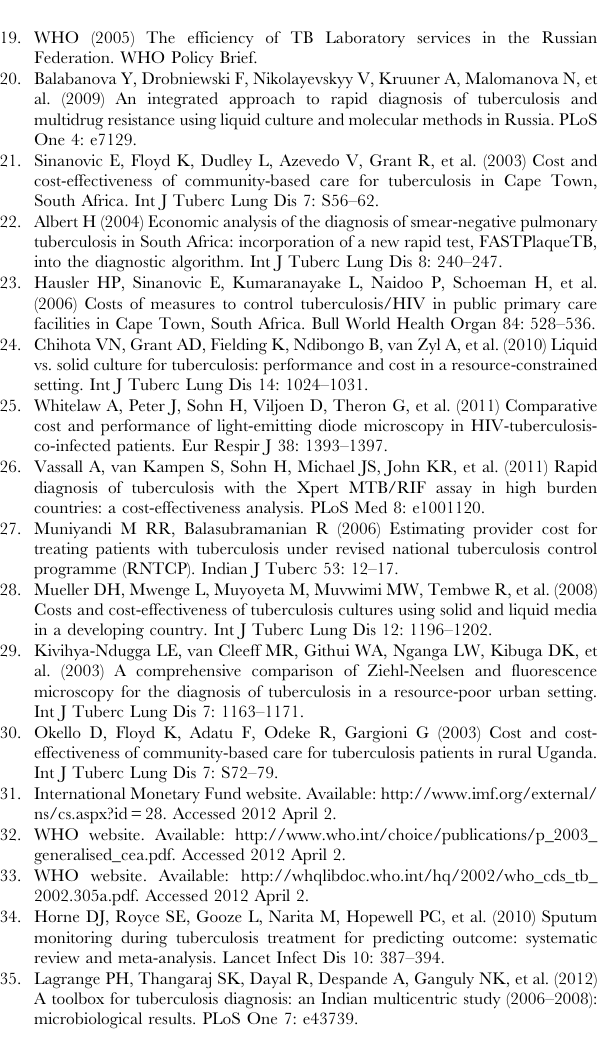
Table S1 Databases and search terms of the search strategy. Table S2 Cost for smear/culture in different regions in China (2010